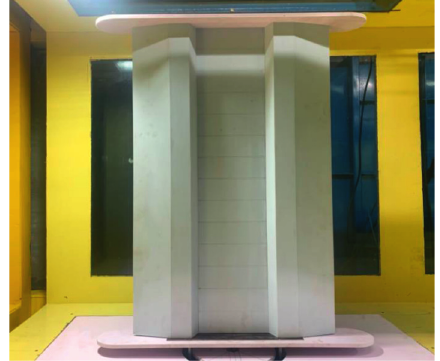
Figure 5: Test model in wind